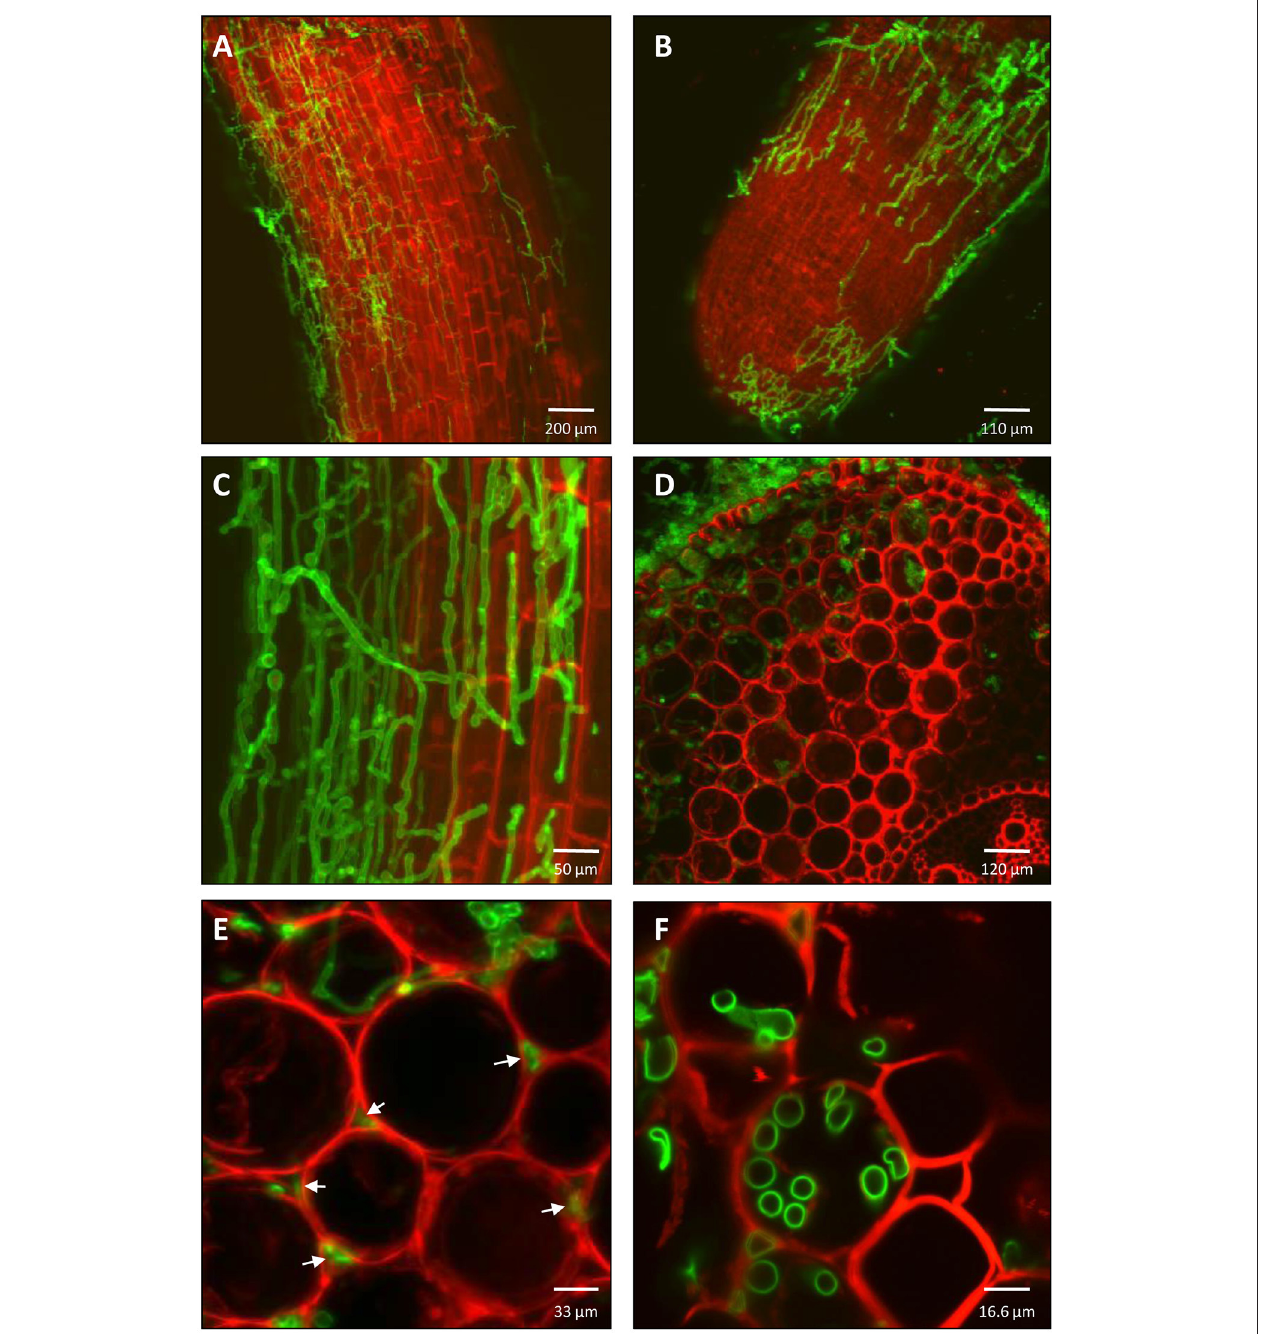
FIGURE 2 | Colonization pattern of T. virens in maize roots. (A) After 5 days post inoculation, T. virens hyphae inhabit epidemical cells of maize primary root and (B) root tip of secondary root. (C) Close up of the hyphae occupying epidemical cells of the differentiation zone of the primary roots. (D) Cross section of primary root showing internal colonization of epidermal and cortical layers near to vascular system. (E) Intercellular and (F) intracellular colonization of cortex cells by T. virens hyphae (arrows). Fungal and plant cells were detected using WGA-Alexa Fluor 488 (green channel), propidium iodide (PI) and FM 4-64 Dye (red channel). Plant cell walls were detected with PI (A-F) and plant plasma membrane with FM 4-64 (D-F) . Fungal cells were detected with WGA-Alexa Fluor 488 (A-F) . Images were obtained with a confocal microscope. the 50–15 kDa fractions. Four maize proteins identified from kDa fractions. Proteins that were only present in the un- the inoculated samples exclusively were in the 120–30 kDa inoculated samples included two peroxidases (C0PGF4_MAIZE; fractions: methionine synthase (Q8W529_MAIZE), heat shock A0A1D6PD14_MAIZE) and a pathogenesis-related protein protein 70 (A0A1D6MWU7_MAIZE), adenosylhomocysteinase 1 (PR-1) (A0A1D6K5Y8_MAIZE) which were identified in Frontiers in Plant Science |